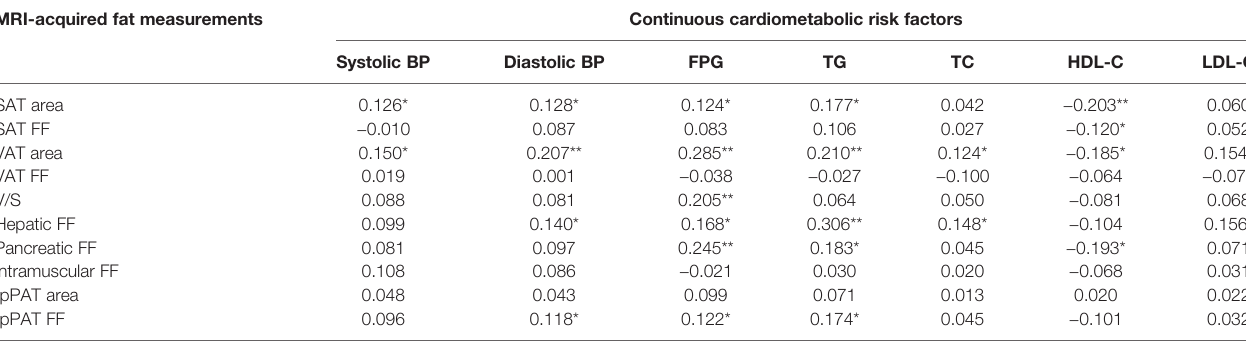
TABLE 3 | The age- and sex-adjusted correlations between MRI-acquired fat measurements and continuous cardiometabolic risk factors. MRI-acquired fat